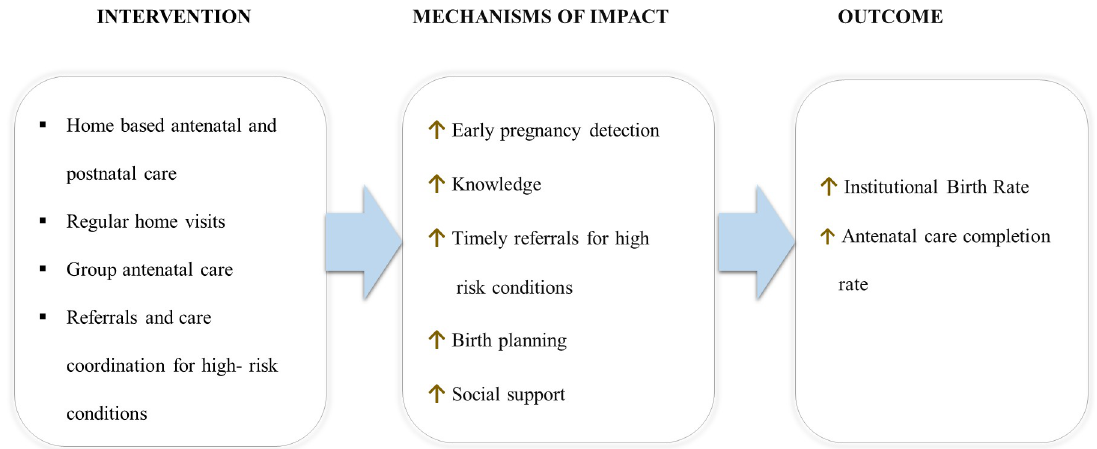
Fig 1. Conceptual model for antenatal and postnatal components of the integrated